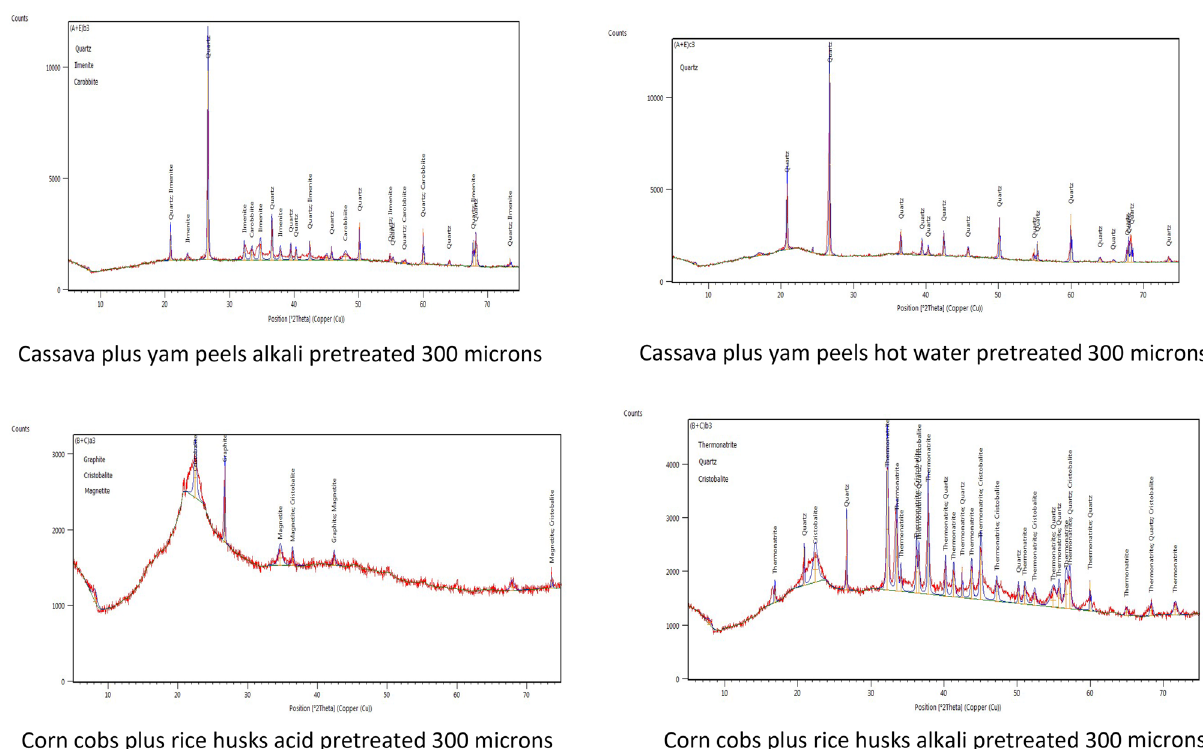
Figure 3. XRD diffractograms of mixed